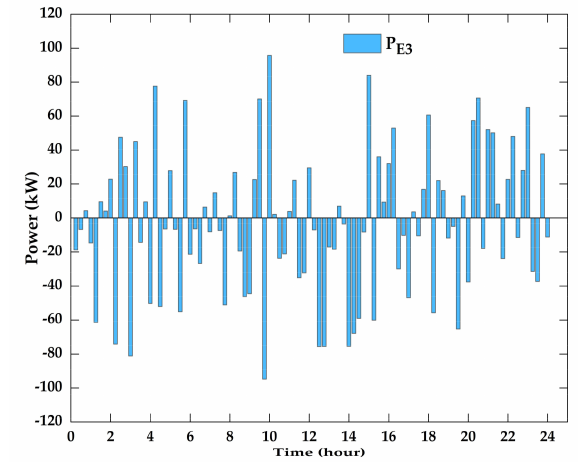
Figure 20. Exchange power of module